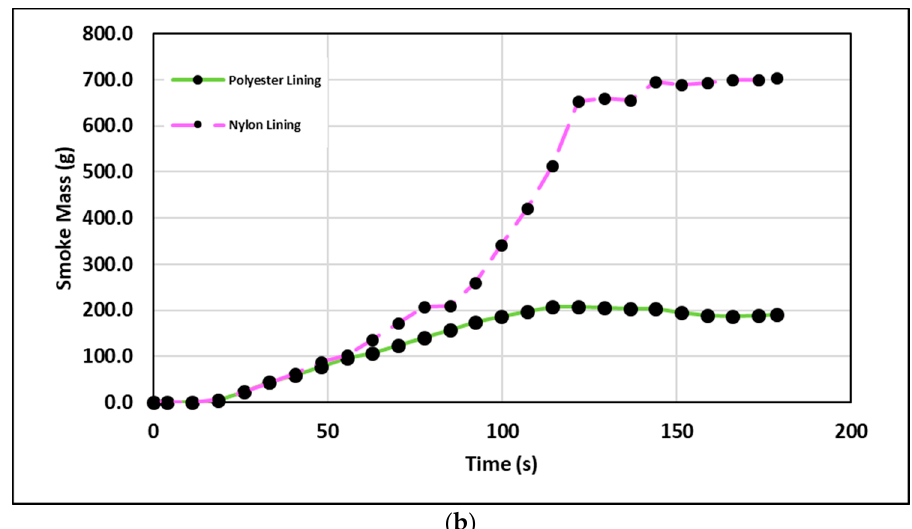
Figure 13. ( a ) Smoke density comparison for different seating materials. ( b ) Smoke mass variations for different seating materials.